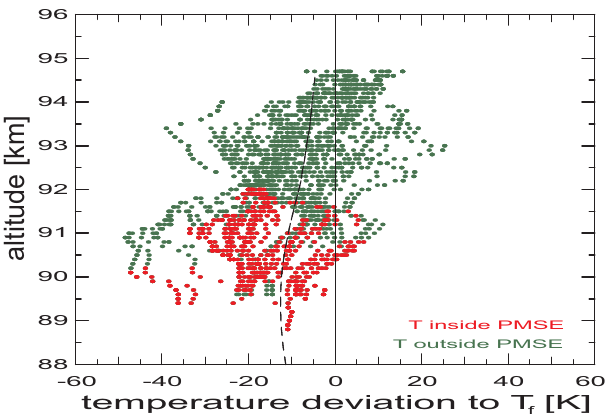
Fig. 3. Deviation of the actual measured temperature compared to T f without freeze-drying-effect on 6 July 2003. Green dots indi- cate the temperature outside and the red dots inside (at the topside 1 z ± 200m) of the PMSE. For comparison T f with freeze-drying- effect is given as dashed